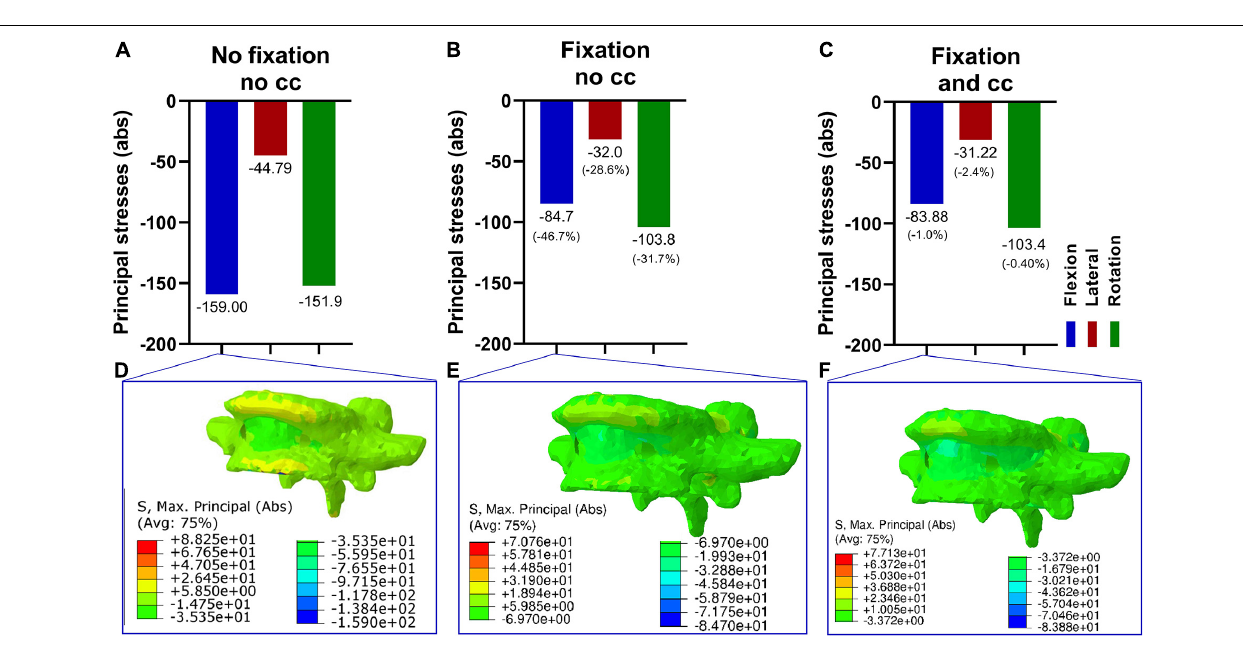
FIGURE 4 | Maximum principal stresses (absolute values) in the fifth vertebra in three loading conditions (A–C) and corresponding stress distribution exemplarily depicted in the F/E situation (D–F) . Without fixation (A,D) , the resulting principal stresses in F/E and rotation were higher compared to the fixation procedure (B,C,E,F) . Upon fixation without cross connector (B,E) and with cross connector (C,F) , the differences appeared to be